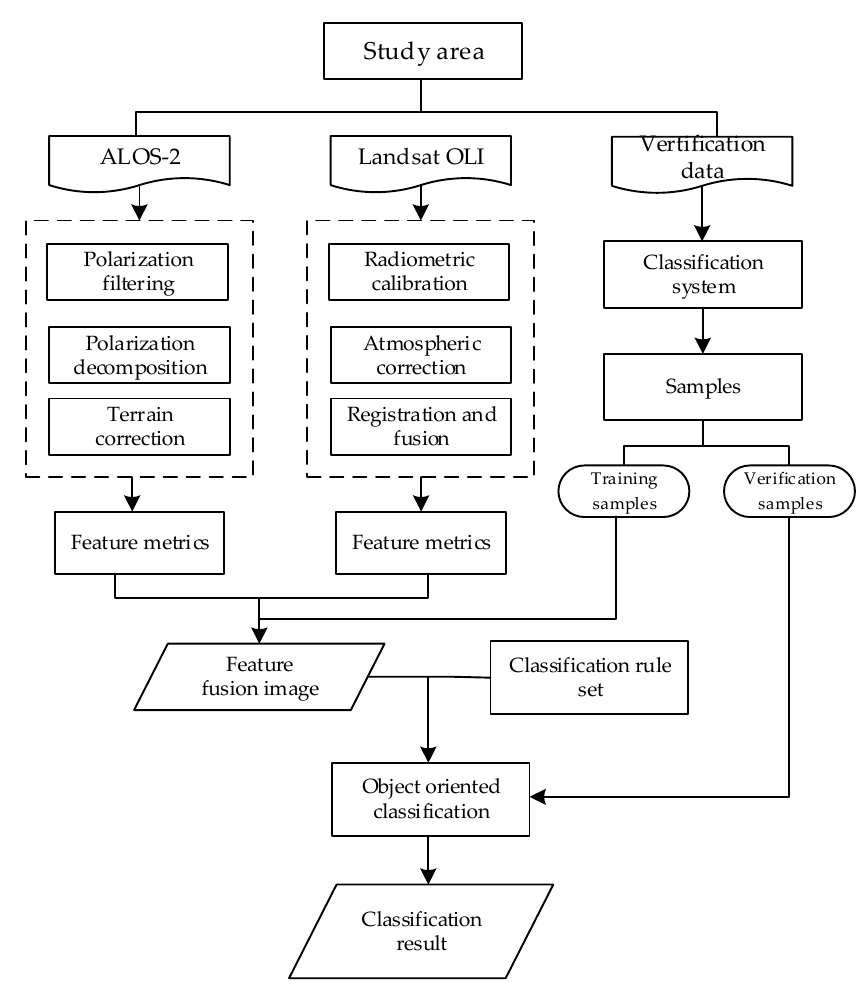
Figure 6. Land use / land cover (LULC) classification strategy in cloudy mountainous Figure 6. Land use/land cover (LULC) classification strategy in cloudy mountainous areas.